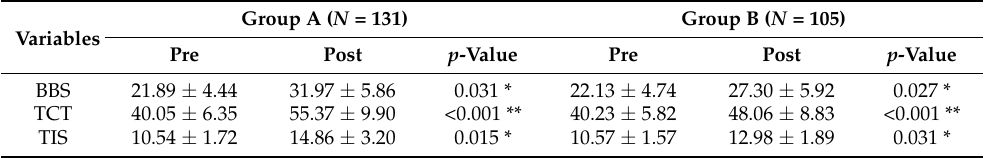
Table 3. Change of balance function by treatment within the group.